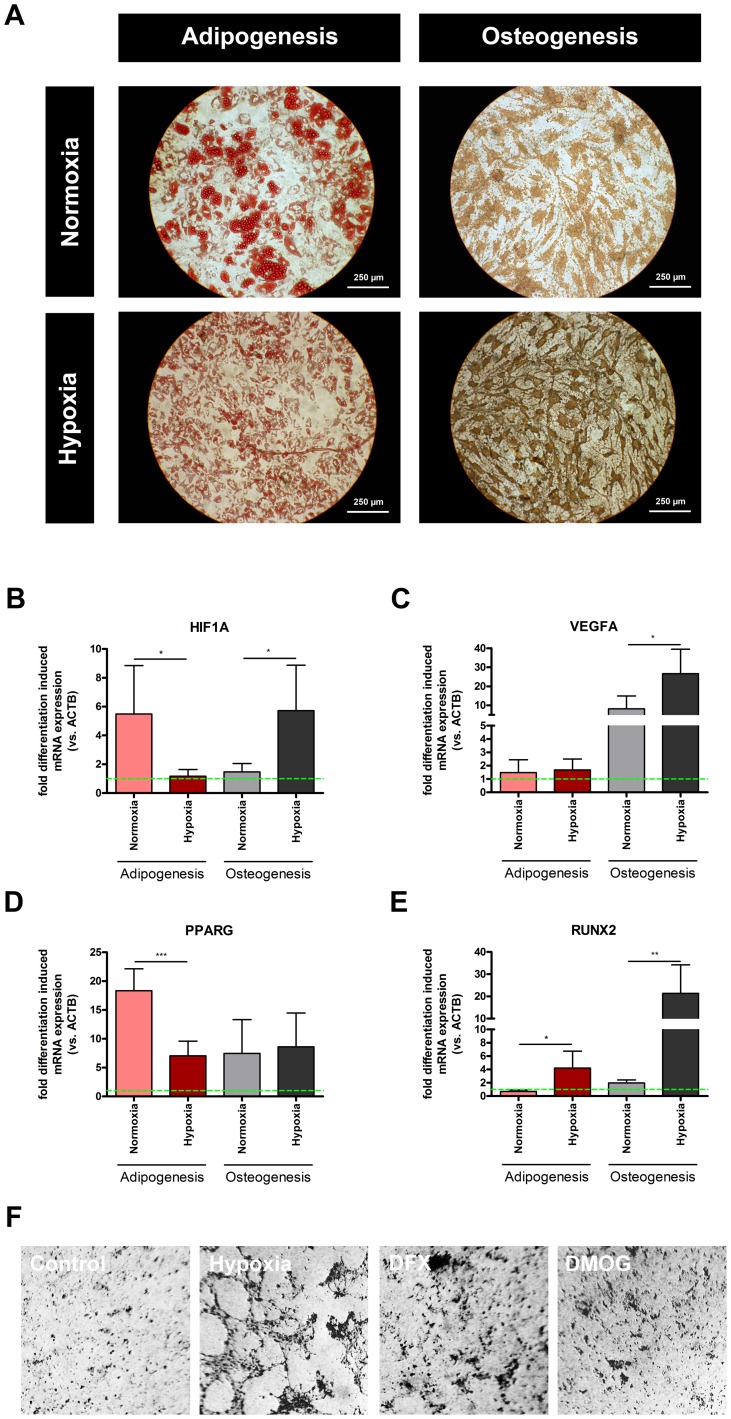
Hypoxia suppresses adipogenic and promotes osteogenic differentiation of human MSCs.(a) Oil-Red-O stain for the analysis of adipogenesis and von-Kossa stain for the analysis of osteogenesis of MSCs incubated under normoxia (≈18% pO2) or hypoxia (1% pO2) for 4 weeks using either osteogenic or adipogenic differentiation medium (scale indicated on the figures; n = 6). (b) HIF1A, (c) VEGFA, (d) PPARG and (e) RUNX2 gene expression of MSCs incubated under normoxia (≈18% pO2) or hypoxia (1% pO2) for 2 weeks using either osteogenic or adipogenic differentiation medium as obtained by real-time PCR (n = 6; unpaired t-test; dotted-line indicates normalisation to gene expression of undifferentiated cells; * p<0.05). (f) Analysis of osteogenesis by von-Kossa stain of MSCs incubated under normoxia (≈18% pO2) without treatment, or with either 250 µM DFX and 100 µM DMOG, respectively (scale indicated on the figures; n = 3).